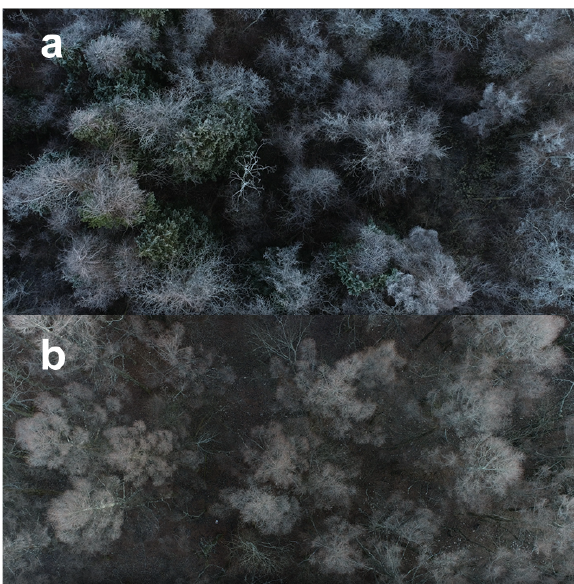
Figure 6 . Screen shots of movie file acquired by Phantom 4 RTK; evergreens and dense trees (a) and sparse larch trees (b).